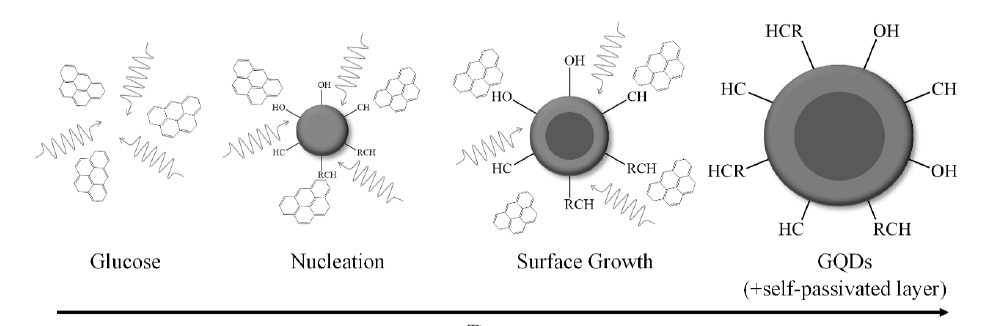
Figure 3: Microwave-assisted hydrothermal synthesis of graphene quantum dots from glucose precursor (Tang et al .,